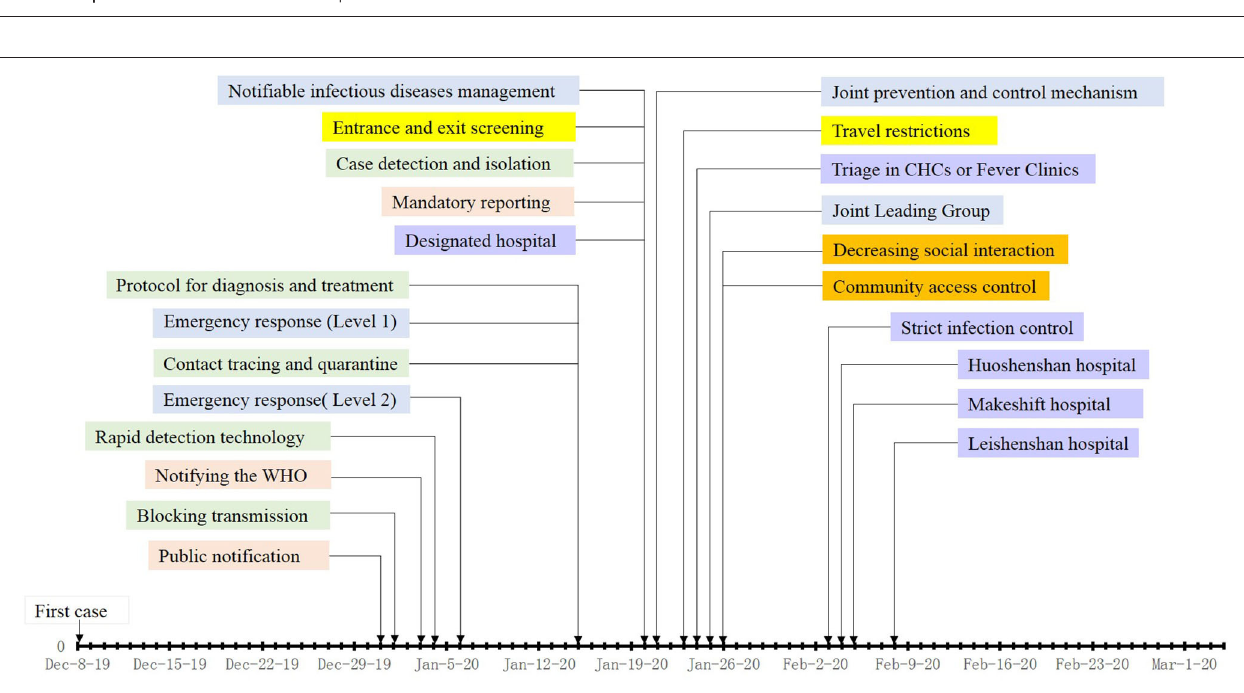
FIGURE 2 | Timeline of control measures implemented in